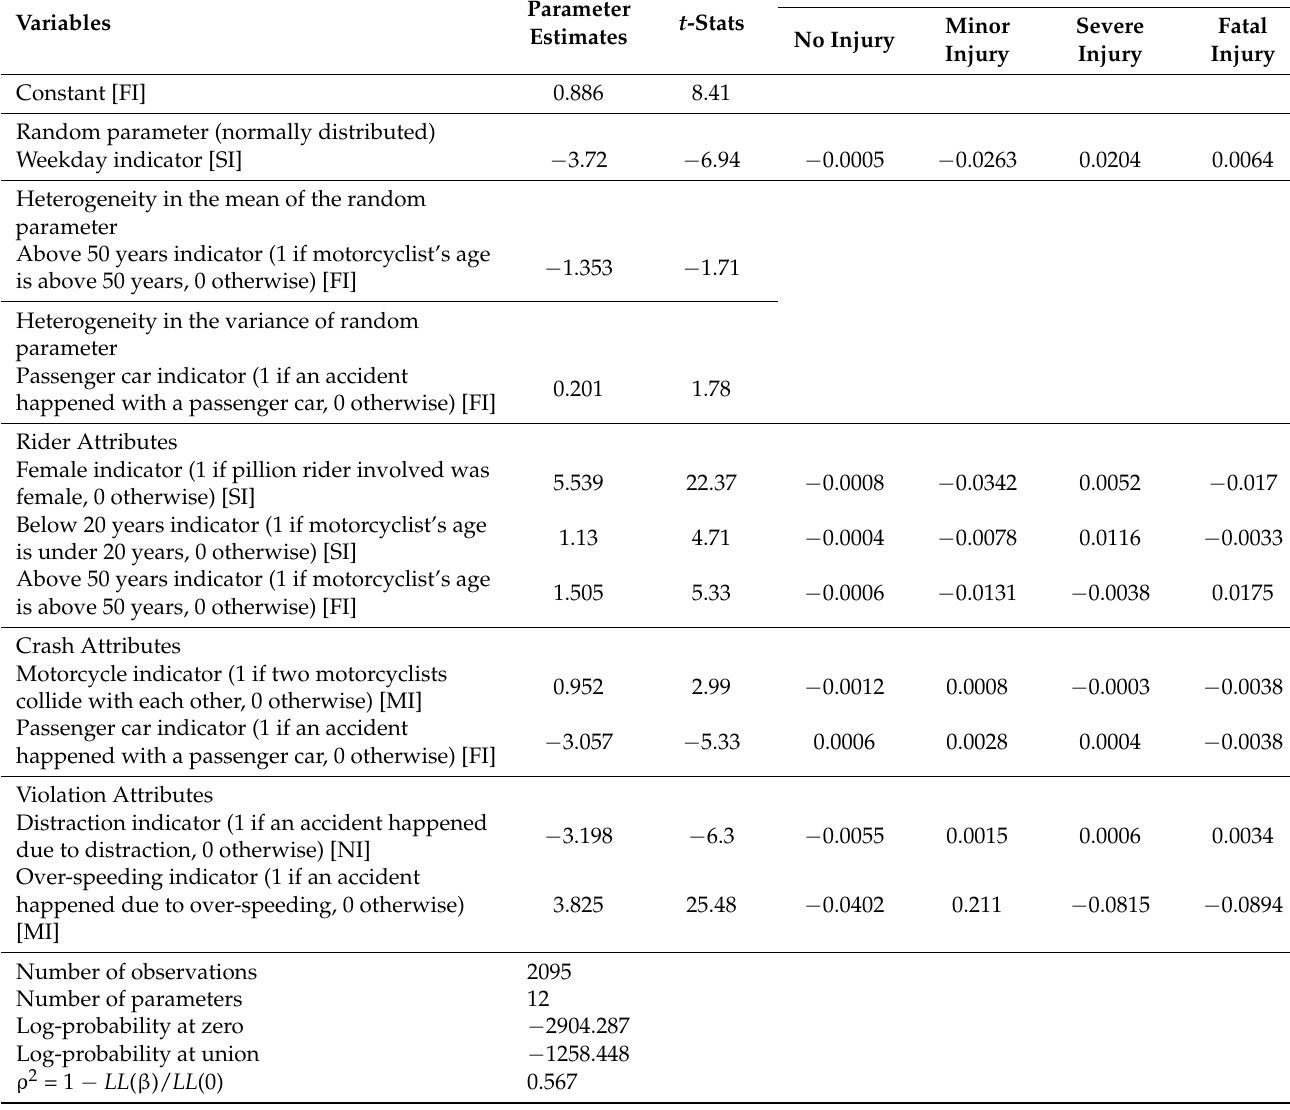
Table 7. Model estimation results for helmet-wearing motorcycle crashes 2018.